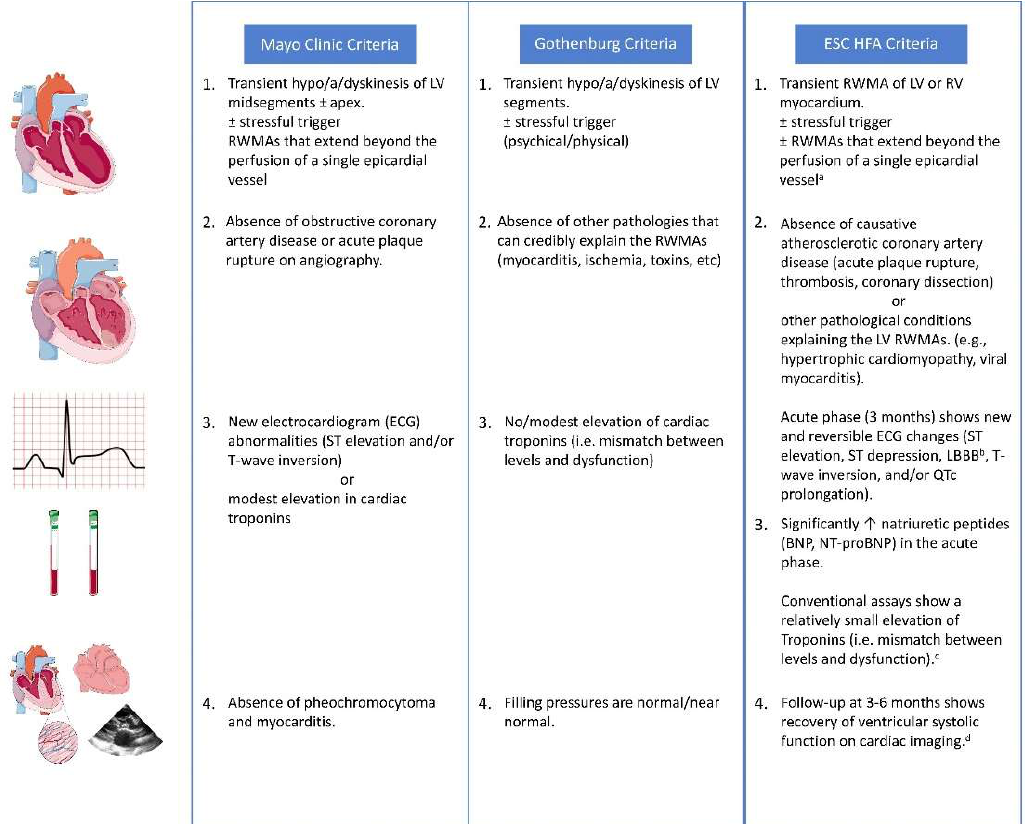
Figure 3. A comparison of various diagnostic Criteria. Mayo Clinic Criteria [93,94], Gothenburg Criteria [95], and ESC Heart Failure Association Criteria [8]. a Acute, reversible dysfunction of a single coronary territory. b Left bundle branch block may be permanent after Takotsubo Syn- drome, but other cardiomyopathies should be excluded. c Troponin-negative cases are atypical. d Small apical infarcts and bystander subendocardial infarcts independently leading to regional wall motion abnormality is doubtful. ESC HFA: European Society of Cardiology Heart Failure Association. Figure attribution: Parts of the figure were drawn using pictures from Servier